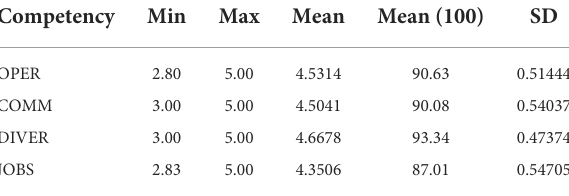
TABLE 1 Descriptive statistics of the required competencies.